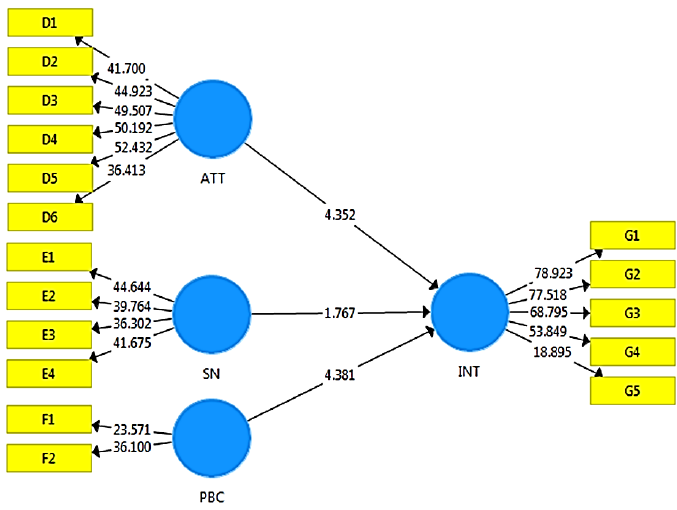
Figure 2. Structural